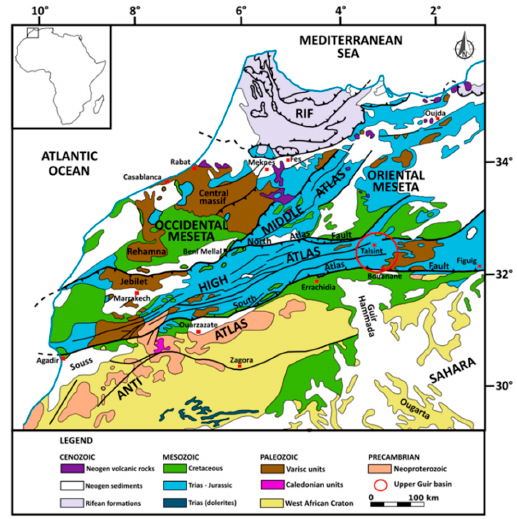
Figure 2. Location of study area close to the eastern border of Moroccan High Atlas.